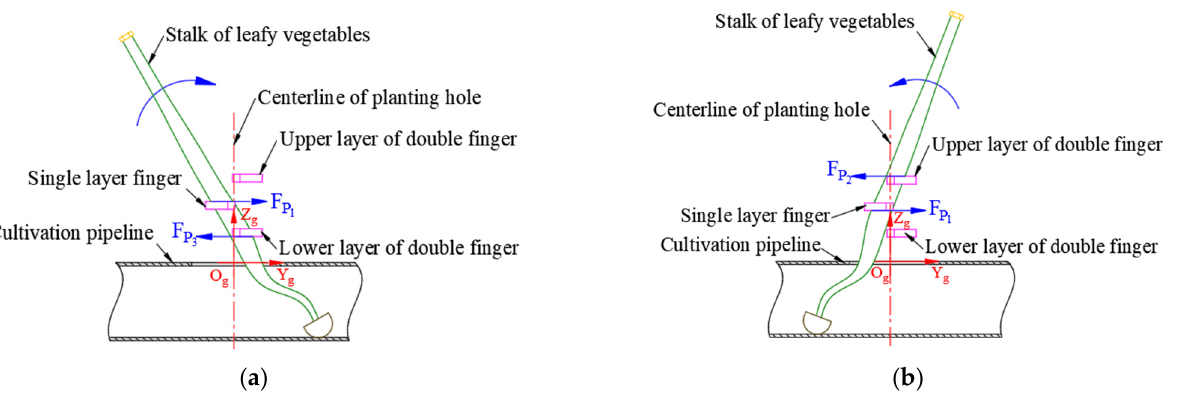
Figure 6. Envelope centering and grabbing principle of the two V-shaped cross fingers: ( a ) the centering and grabbing principle of the single-layer finger and the lower layer of the double-layer finger; ( b ) the centering and grabbing principle of the single-layer finger and the upper layer of the double-layer finger.